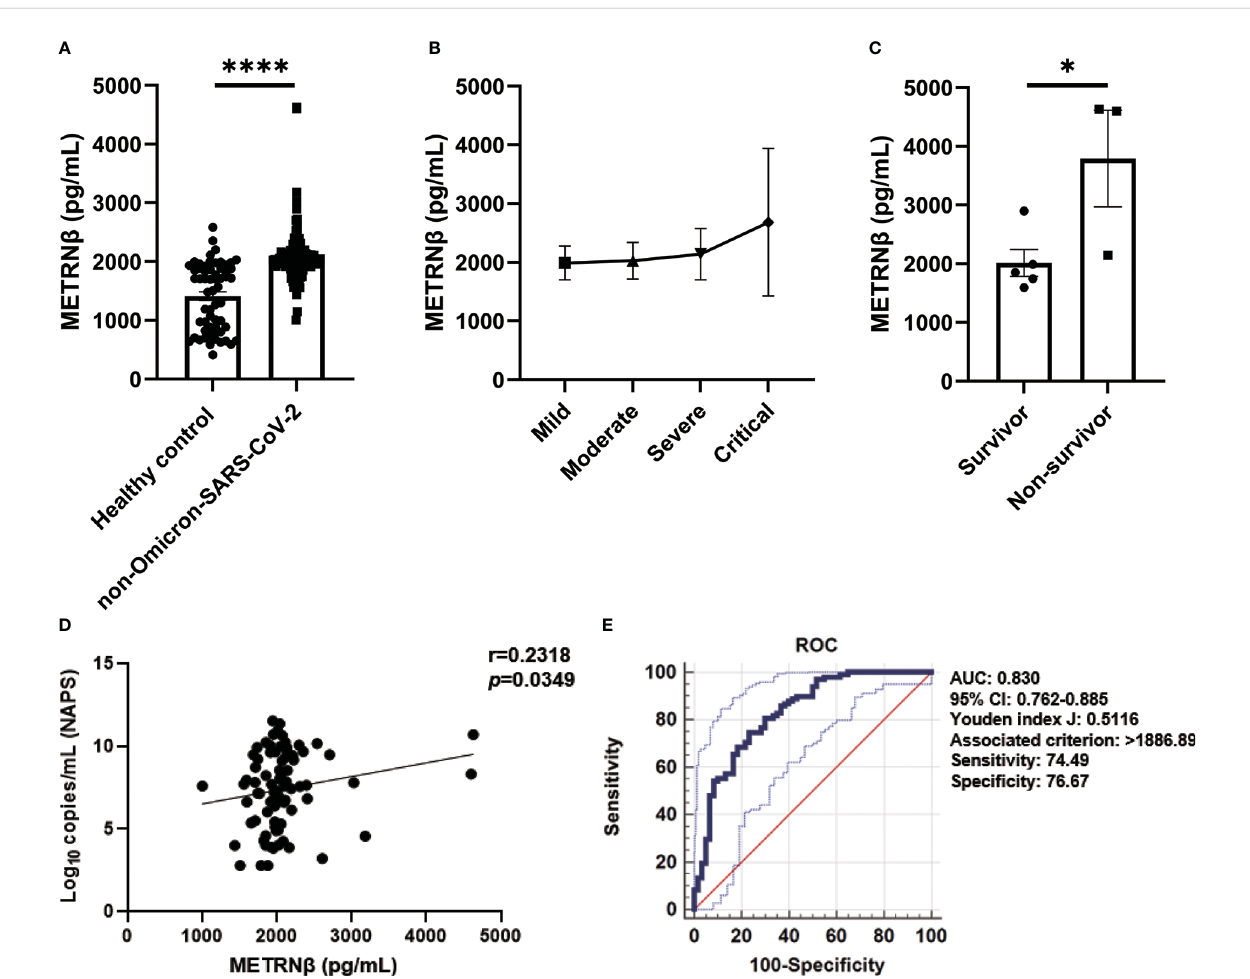
FIGURE 1 METRN b expression increased in non-Omicron-SARS-CoV-2 infected COVID-19 patients of the prediction cohort. (A) Circulating METRN b concentrations in COVID-19 patients (n = 98) and healthy controls (n = 60) detected by ELISA. (B) COVID-19 patients were strati fi ed into mild (n = 36), moderate (n = 41), severe (n = 13), and critical groups (n = 8), and circulating METRN b levels in serum were detected by ELISA. (C) Serum METRN b concentration of the non-survivors (n = 3) and survivors (n = 5) among the critical patients was measured by ELISA. (D) Correlation analysis of serum METRN b concentrations with viral loads in the NAPS in patients with non-Omicron-SARS-CoV-2 infections (n = 83). (E) Receiver operating characteristic curves of serum METRN b levels on admission to distinguish COVID-19 patients from healthy controls. The AUC was 0.830 (95% CI: 0.762 – 0.885) for serum METRN b levels on admission in the prediction cohort of COVID-19 patients with non-Omicron-SARS-CoV-2 infection (n = 98). Data were shown as the mean ± SEM. The Mann – Whitney test was used to compare the differences between groups. Spearman ’ s correlation coef fi cient was used in the statistics for correlation analysis. NAPS, nasopharyngeal swab specimens; AUC, area under the curve. * P < 0.05 and **** P <